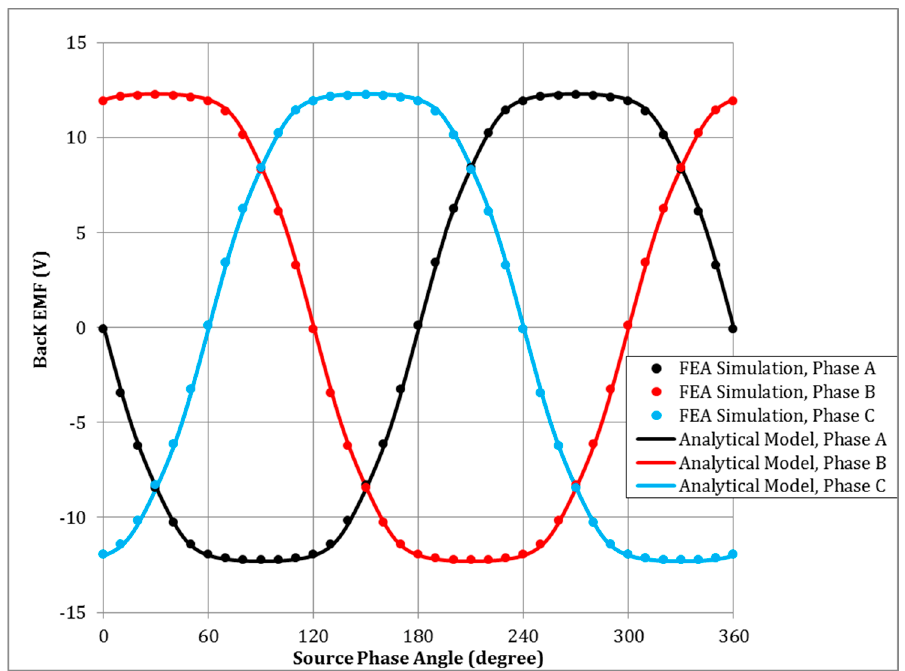
Figure 14. Analytical and MotorSolve Predictions of Back EMF in the 12 s/10 p Conventional Machine.